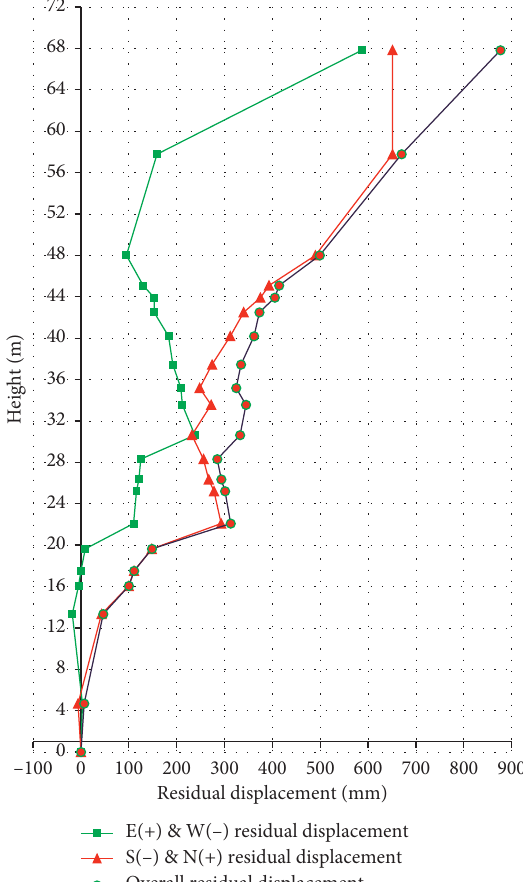
Figure 9: Residual horizontal deformation at the centre of each structural level relative to the central projection of the foundation.